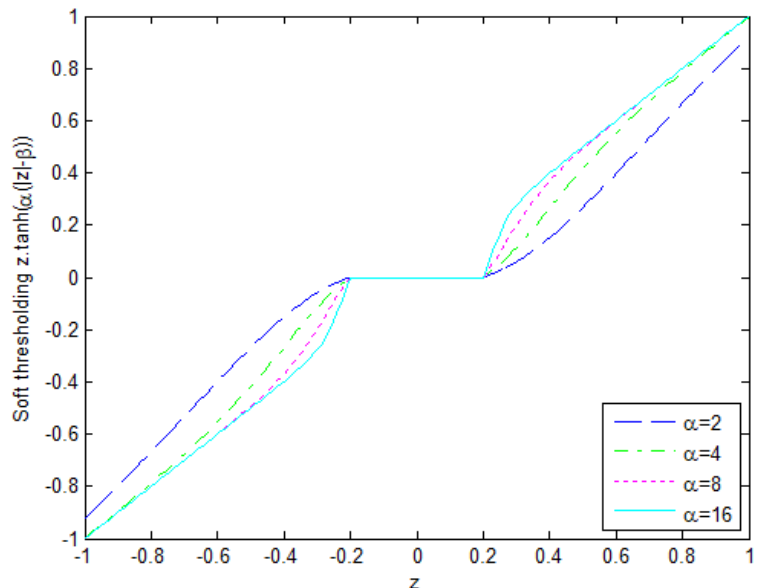
Figure 4. Hyperbolic tangent function based thresholding for alpha 𝛼 = (2, 4, 8, 16), the value of 𝛼 determines the slope of soft thresholding. The proposed method gives us the flexibility to shape the curves using 𝛼 depending upon its application.